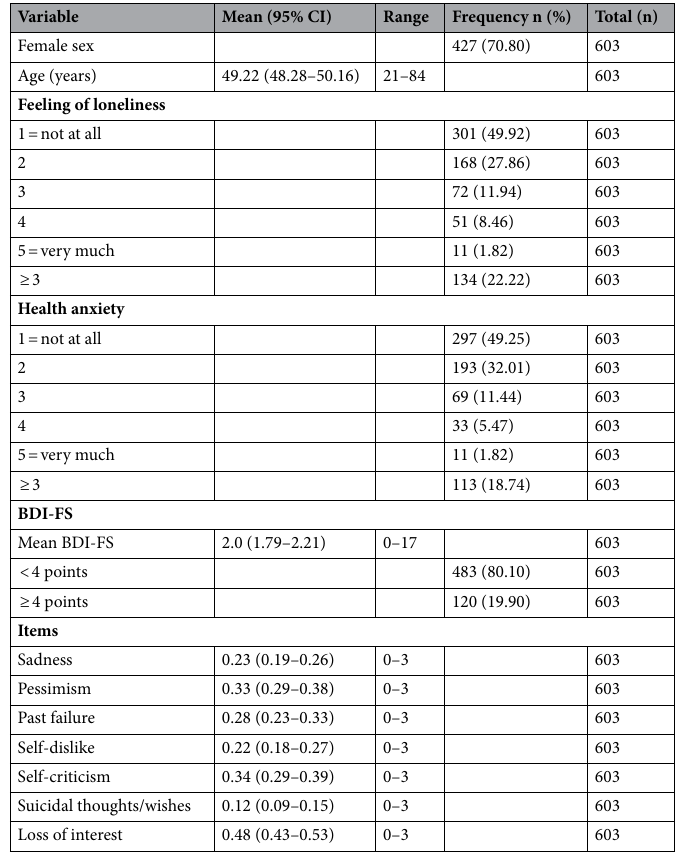
Table 1. Characteristics of the sample of persons with MS. BDI‑FS Beck Depression Index Fast Screen, n number of observations, 95% CI 95% confidence interval, COVID‑19 coronavirus disease